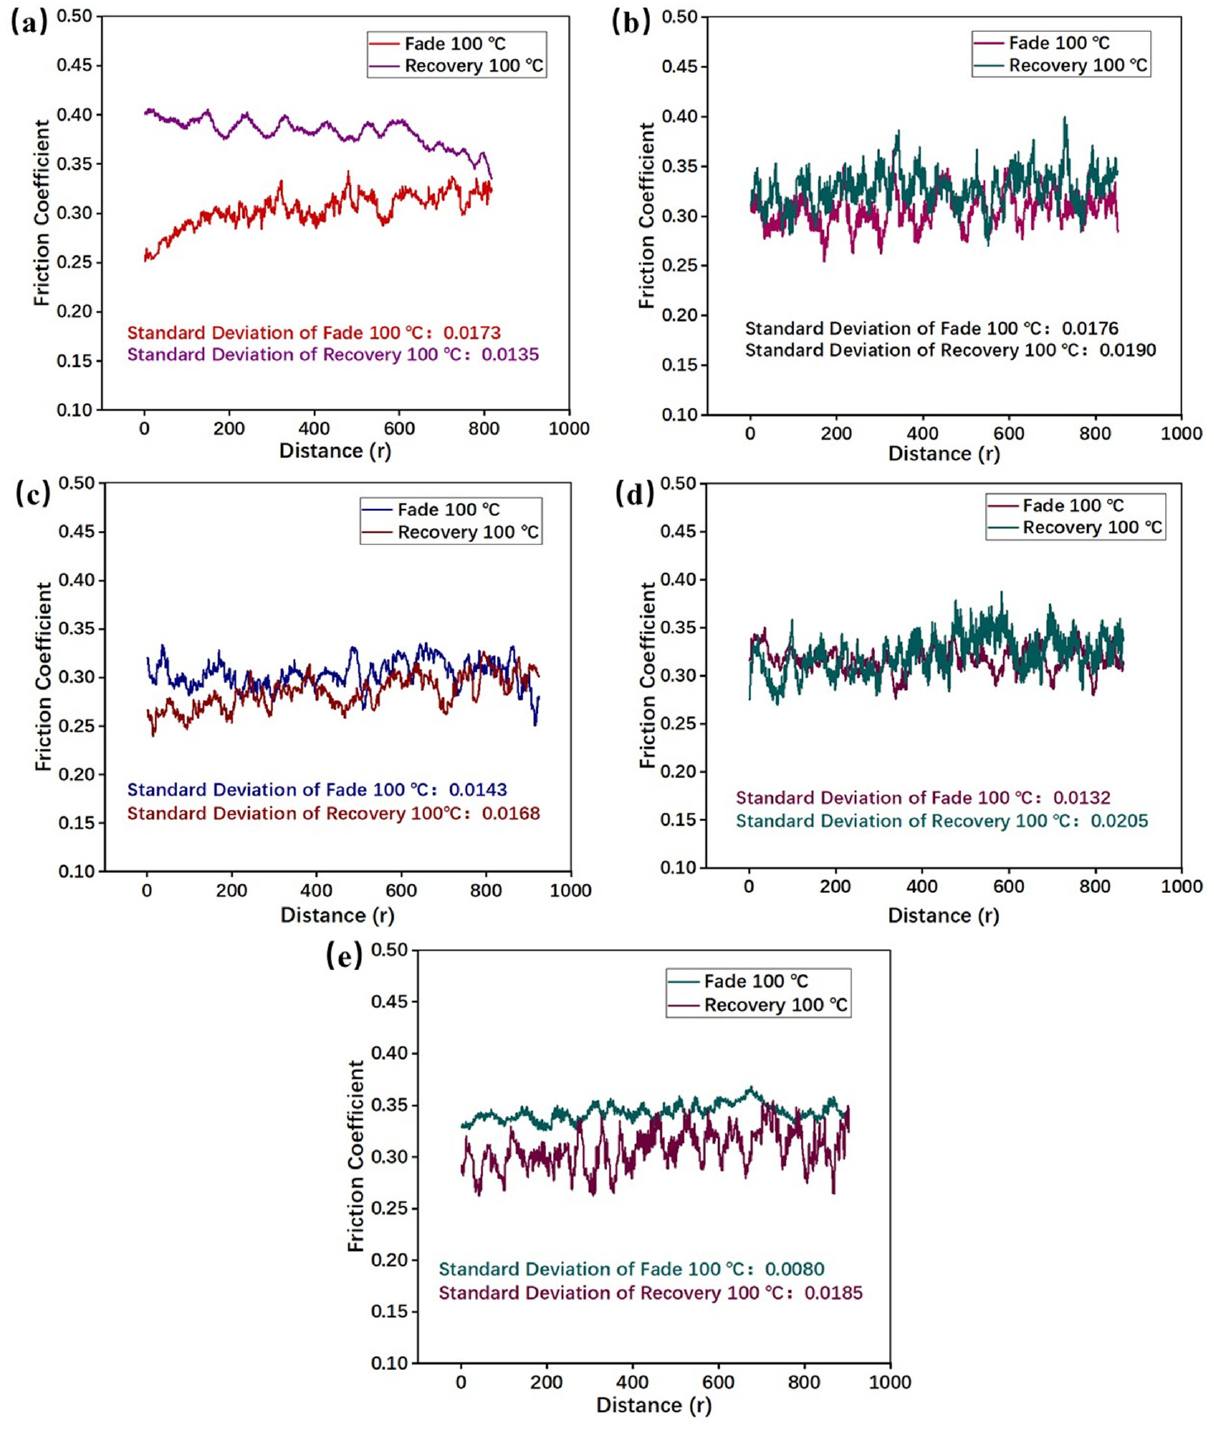
Figure 9. Brake curves of samples during the recovery test at 100 °C and the fade test at 100 °C; ( a ) RBFM-1, ( b ) RBFM-2, ( c ) RBFM-3, ( d ) RBFM-4, ( e ) RBFM-5.